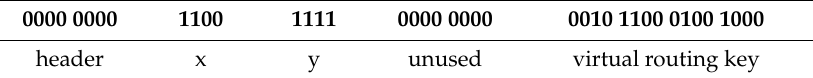
Table 3. DVS resolution reduction event data encoding.